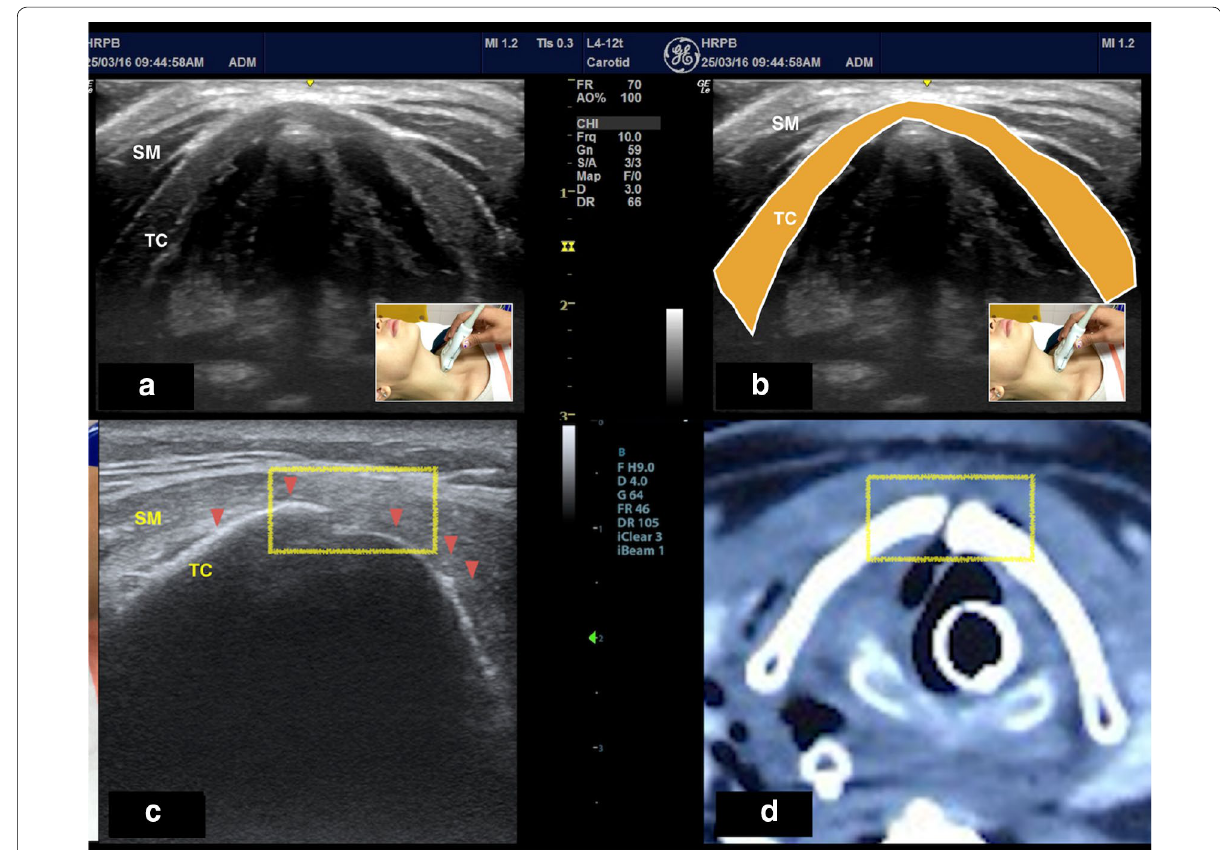
Fig. 2 a , b Surface landmark of the probe position and ultrasound image of the normal thyroid cartilage (in transverse view). c Airway ultrasound showing undisplaced fracture of the thyroid cartilage (box) and disruption of the anterior cortex of the thyroid cartilage (arrowhead ). d A Computerized tomography (CT) scan image shown right thyroid lamina fracture with surrounding prevertebral edema and hematoma.